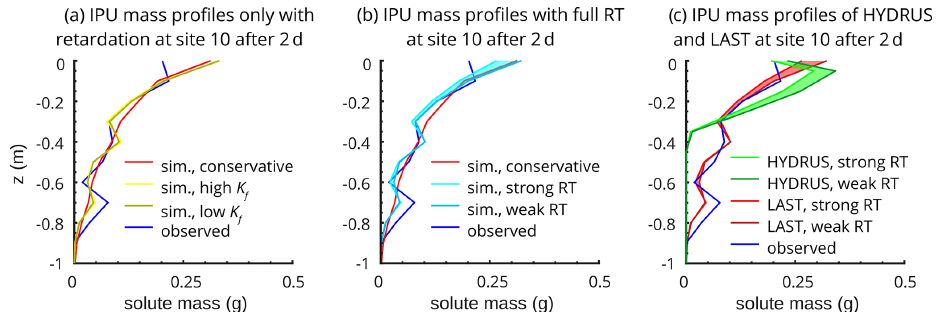
Figure 5. LAST-Model results of reactive IPU transport simulations at the preferential-flow-dominated site (site 10) after 2d. (a) The simulation is performed only with active retardation and with low and high values for K f . (b) The simulation is performed with activated retardation and degradation. The shaded area between the profiles with weak and strong reactive transport (cf. Table 2) shows the uncertainty area of the empirical K f and DT50 values. (c) Comparison with HYDRUS 1-D simulation